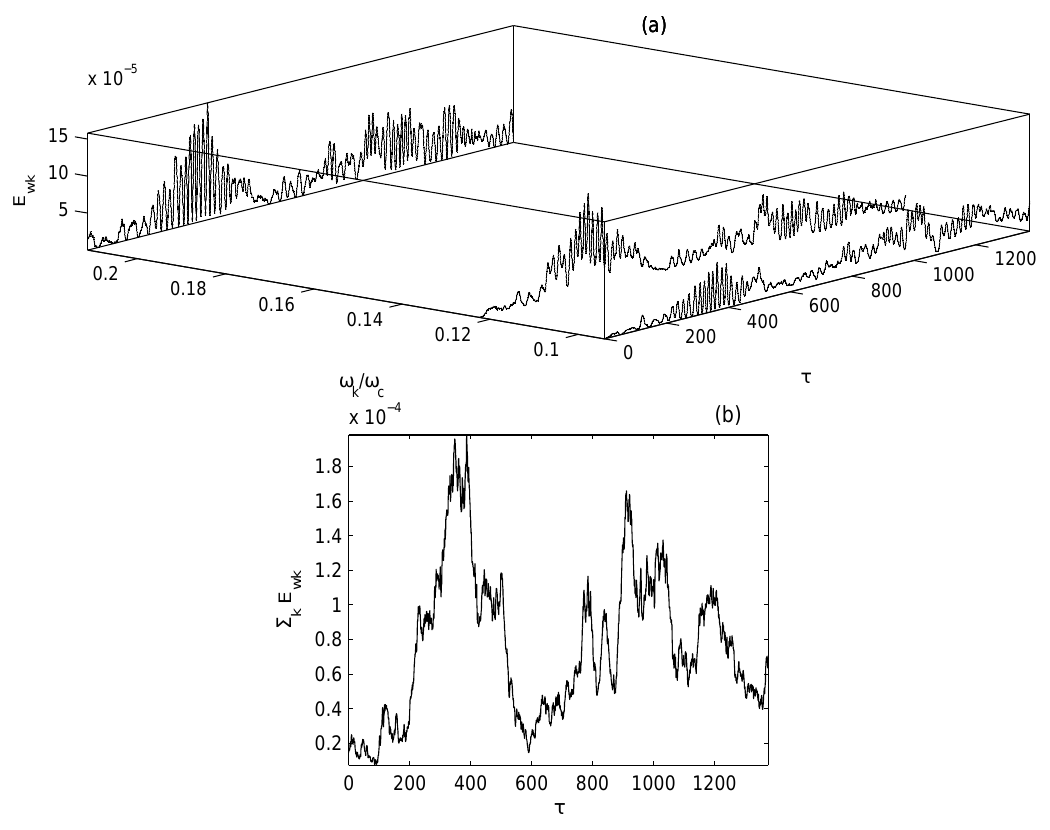
+ ω Fig. 4. Resonant three-waves decay ( k = k 1 + k 2 and ω k = ω k k 2 ) in the presence of a suprathermal tail of electrons extending in the 1 parallel direction v z > 0 (wave-wave interaction terms are not neglected). Variation as a function of the normalized time τ of (a) the normalized wave energy density E wk of each of the three waves (each wave is indicated by its normalized frequency ω k /ω c ) and (b) the total normalized wave energy density P k E wk . The main normalized parameters and the initial particle distribution functions are the same as in Fig.